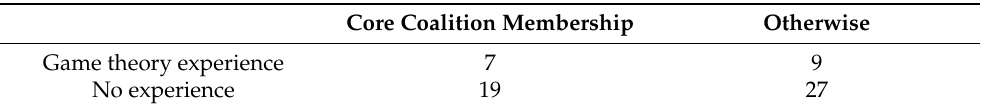
Table 4. A contingency table shows the impact of board game experience on whether human participants’ final coalition was a core coalition.